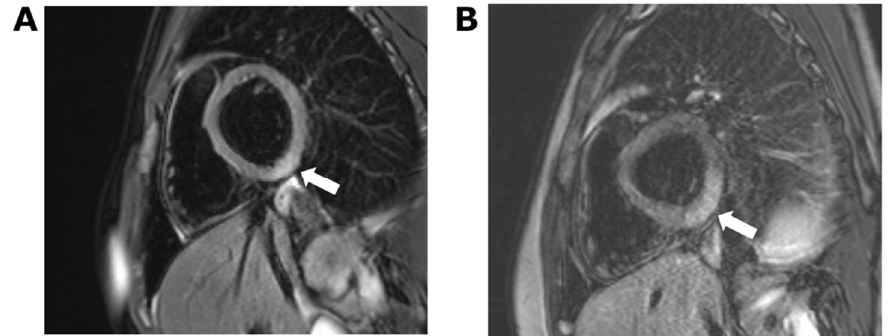
Figure 2. Cardiac MRI showing short-axis T2-weighted image with fat saturation. ( A ) Case 1: ill- defined area of increased signal in the inferior left ventricular myocardium indicative of focal oedema. ( B ) Case 2: more extensive region of oedema in comparison to case 1, which extends into the posterior obtuse marginal surface.